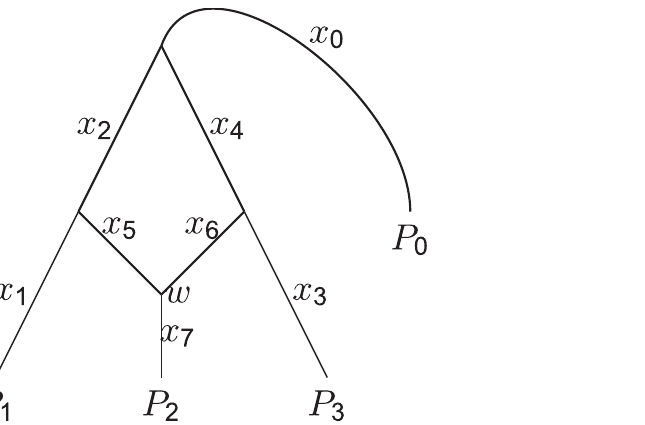
Fig 4. An admixture graph for the 3 populations and one outgroup. Considering a single SNP, the quantities x 1 , ... , x 7 are changes in allele frequency, w is the admixture proportion, and P 0 , P 1 , P 2 and P 3 are allele frequencies in the sampled populations. Note that the edge to the outgroup (labeled with x 0 ) is not given a direction. This is because the Gaussian drift model is reversible, meaning that the population split between the outgroup and the other populations could have happened at any point along this branch and identical allelic covariance matrices would be produced. For simplicity, we model the outgroup as the parent of the root node, as described in Method